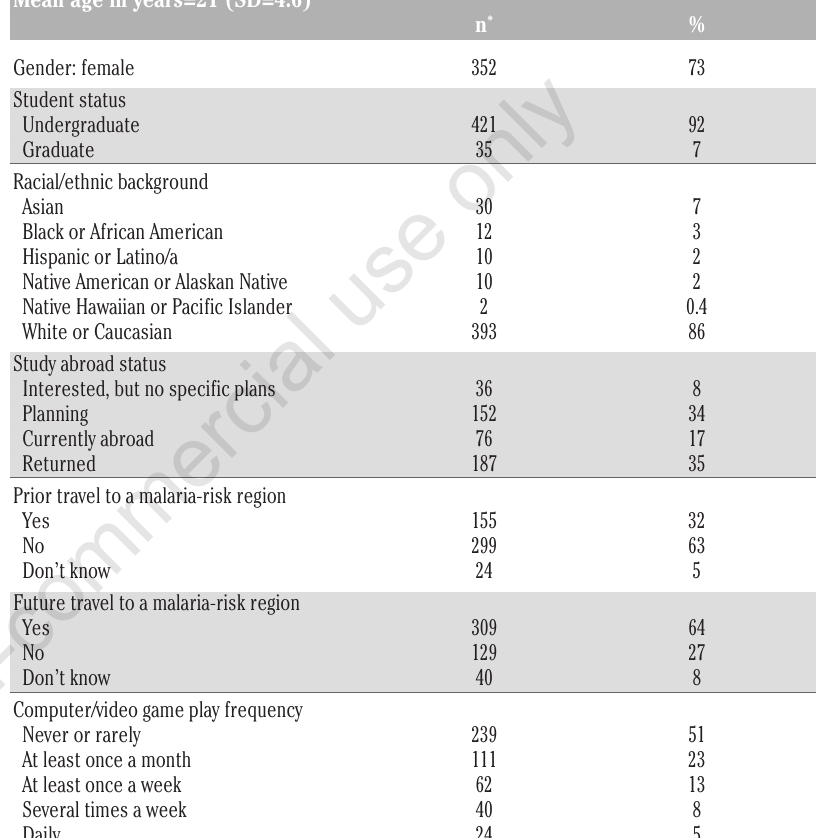
Table 1. Participants’ characteristics.